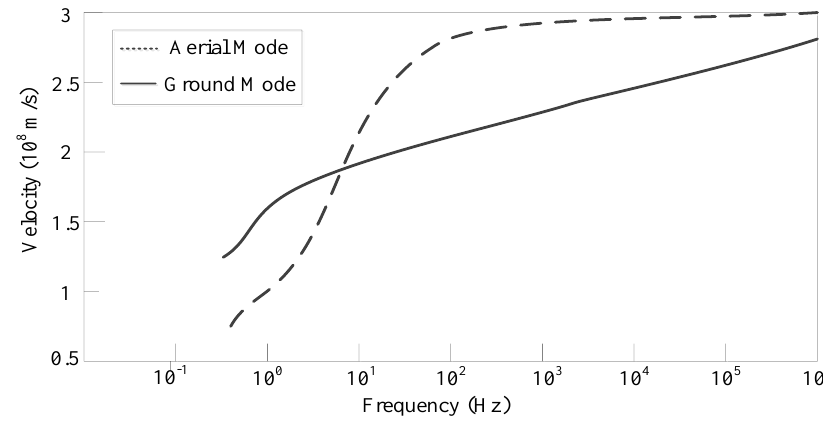
Figure 3. The relationship between velocity and frequency.